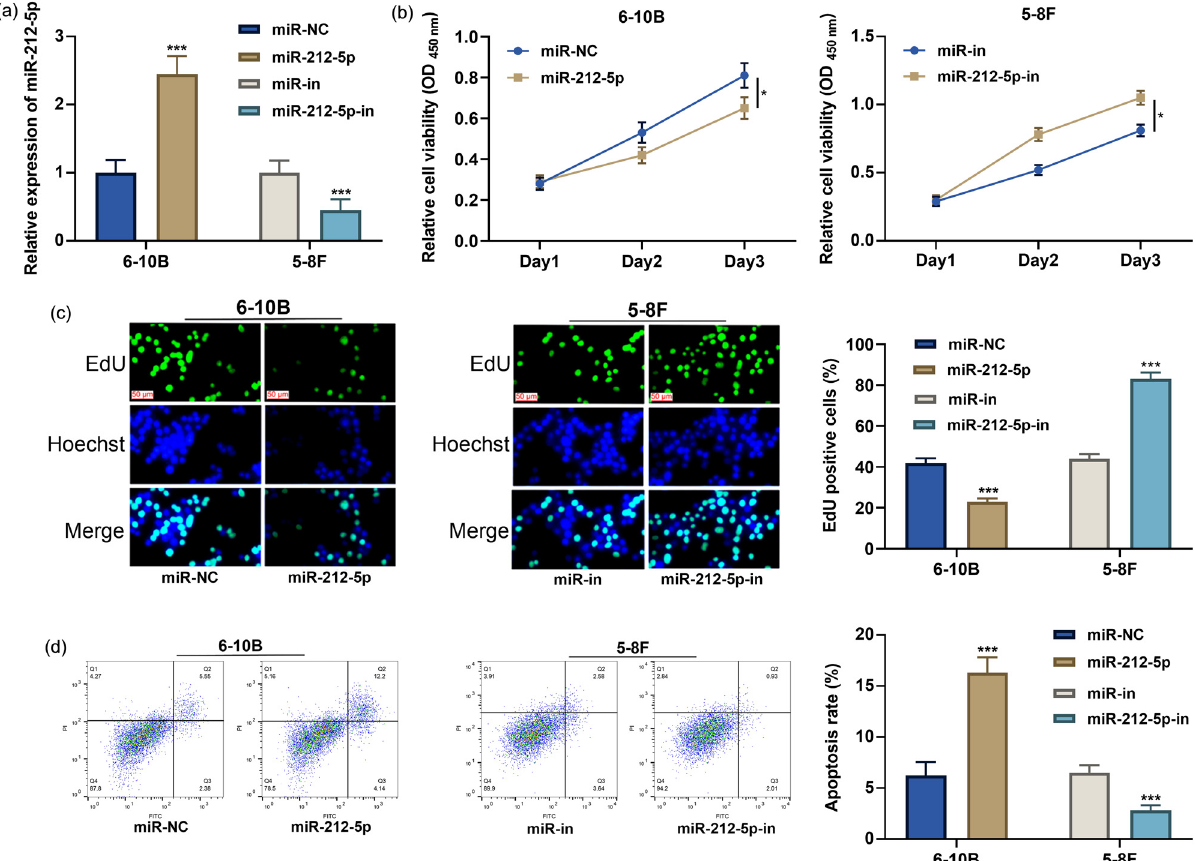
Figure 2: The e ff ect of miR - 212 - 5p on NPC cell proliferation and apoptosis. ( a ) The expression of miR - 212 - 5p in 6 - 10B or 5 - 8F cells transfected with miR - 212 - 5p mimics or inhibitors was detected by qRT - PCR. ( b – c ) After transfection, the cell proliferation was assessed by the CCK - 8 assay and EdU assay. ( d ) After transfection, the cell apoptosis was assessed by fl ow cytometry. *P < 0.05, **P < 0.01, and ***P <